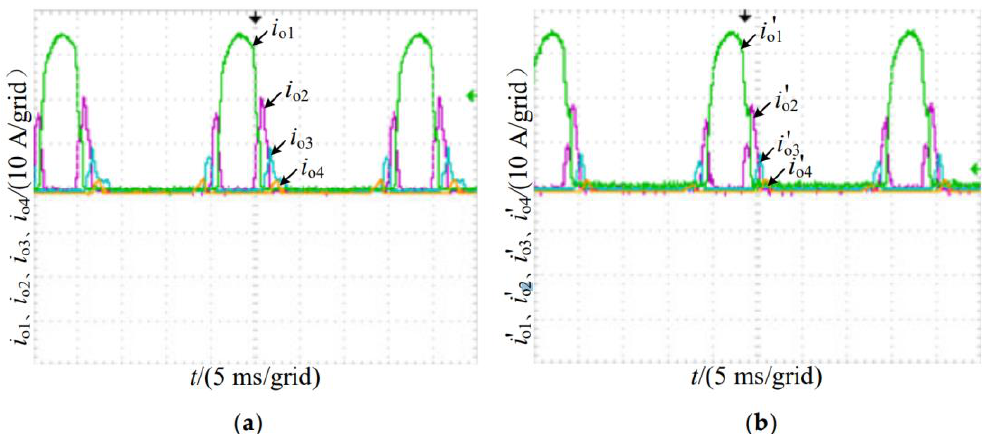
Figure 11. Current waveform of 4-stage HDCPLN. ( a ) Current on upper transistor at each stage. ( b ) Current on upper transistor at each stage.